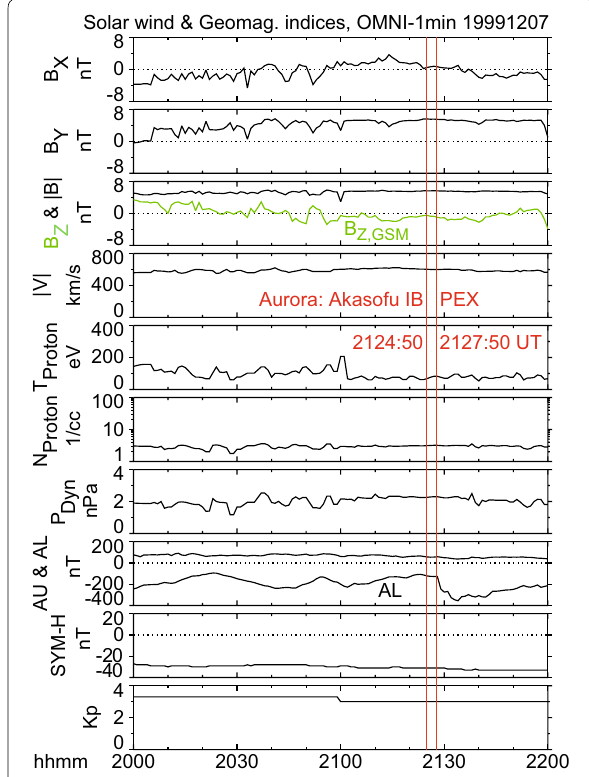
Fig. 8 Solar wind parameters and geomagnetic indices on December 7, 1999. These data were obtained from the Operating Missions as Nodes on the Internet (OMNI) data set. The red vertical lines indicate the Akasofu initial brightening (AIB; 2124:50 UT) and the poleward expansion (2127:50 UT) identified by using all-sky images (ASIs). The solar wind parameters were time-shifted with respect to the bow shock nose. Geocentric solar magnetospheric (GSM) coordinates were used. The interplanetary magnetic field (IMF) was weakly southward ( B z ∼ − 1 nT ) and strongly duskward ( B y ∼ 6 nT ), indicating moderately favorable conditions for the occurrence of substorms. The AL index (i.e., westward ionospheric current) began to develop at 2129 UT, which is closer in time to the poleward expansion than to the AIB in the